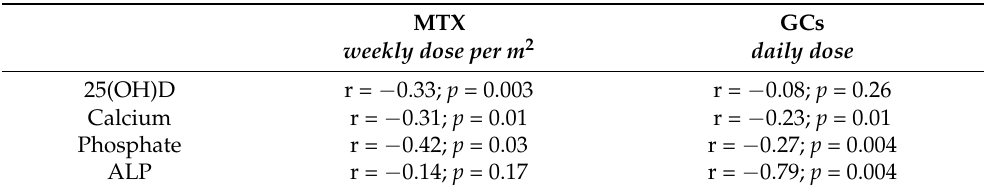
Table 3. Univariate correlations for methotrexate (MTX), glucocorticoids (GCs), and serum cal- cium/phosphate parameters in children with JIA.